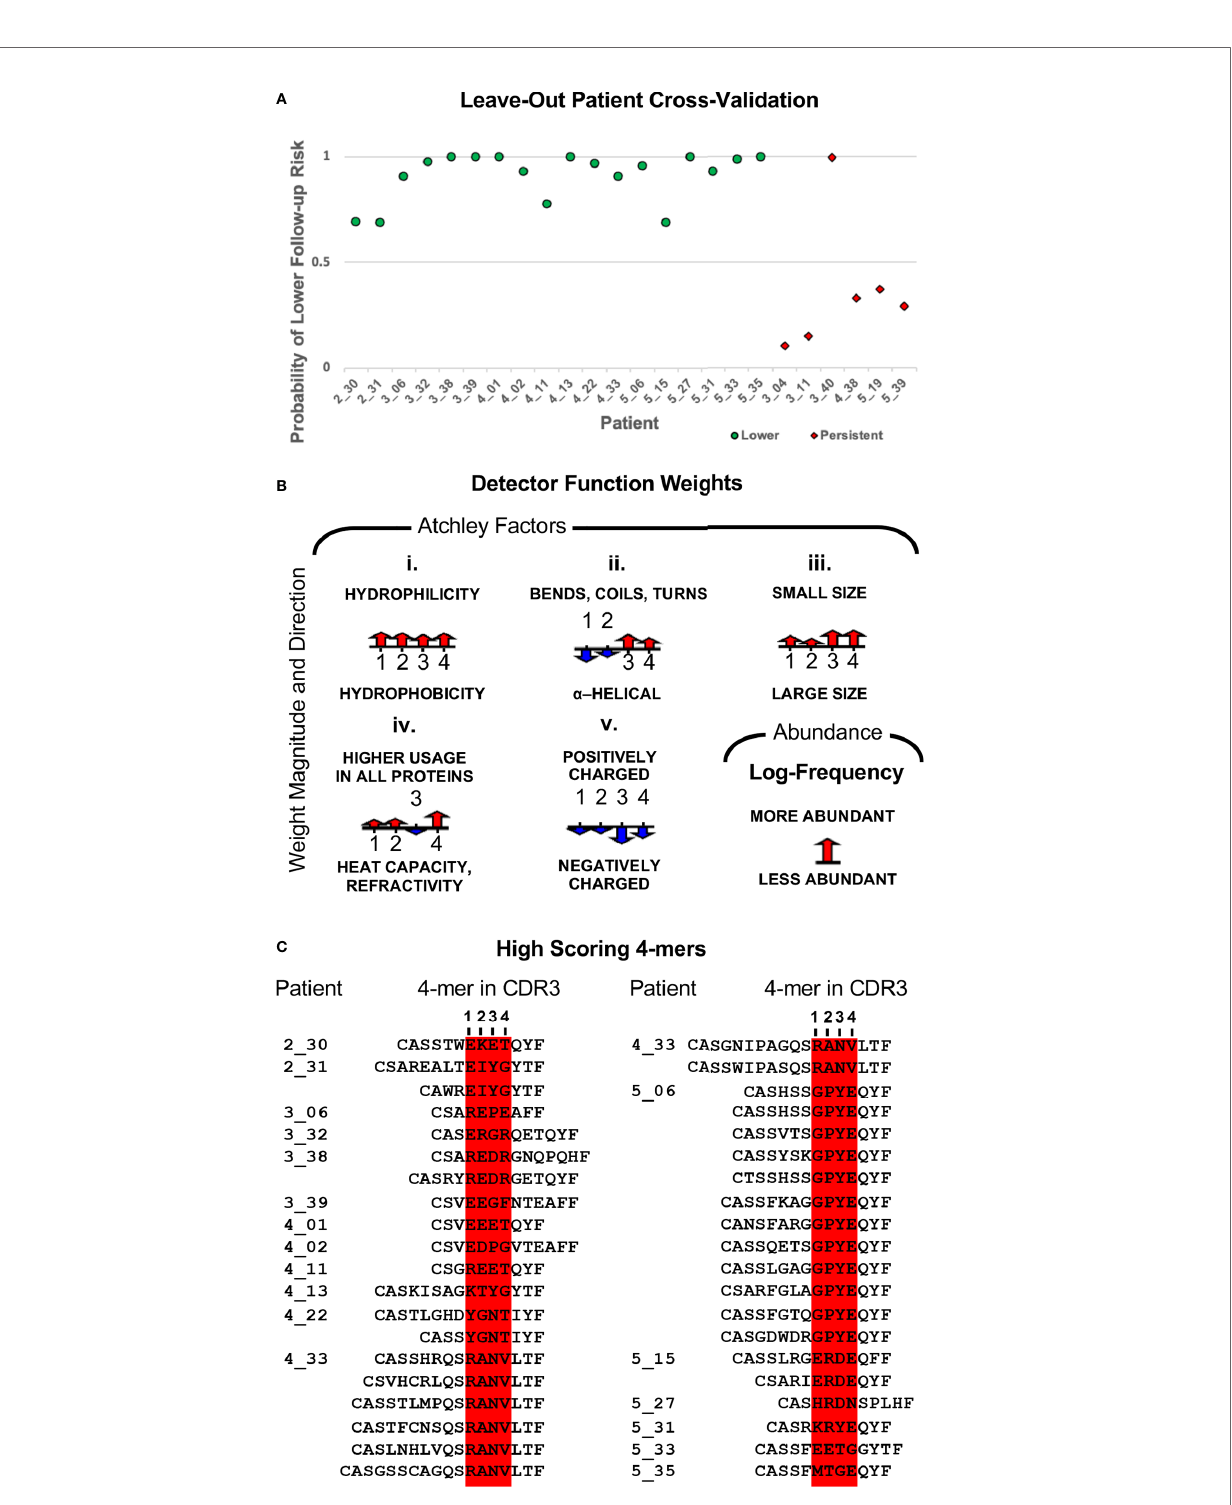
FIGURE 6 | (A) Model classi fi cation accuracy obtained during leave-one-out cross-validation in which all sequences from one sample were held out for validation. The y-axis shows the model-assigned probability that the follow-up sample would be associated with lower risk than the index sample. The x-axis enumerates patients, and the legend indicates how the index sample was classi fi ed for model training. (B) Illustration of the classi fi er weights after fi tting the model to all 24 samples. For each of the fi ve Atchley factors, the weights are shown for the four residue positions. The weight for 4-mer relative abundance is also shown. Positive weight values are shown pointing up, and negative weight values are shown pointing down. The length of the arrow corresponds to the weight ’ s magnitude. (C) The top-scoring 4-mer for each sample is shown in the context of the CDR3s that contain